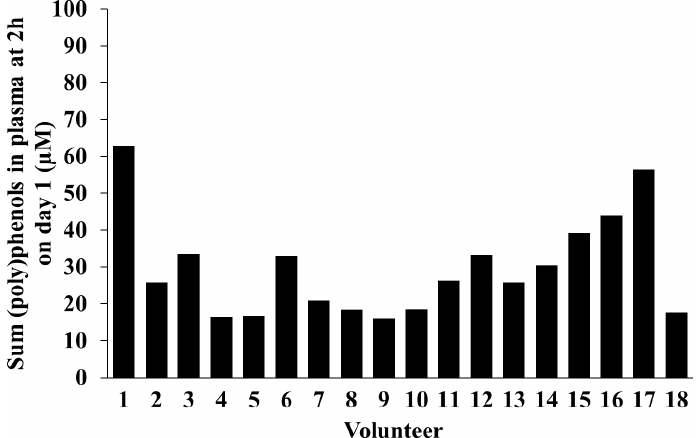
Figure 3. Total (poly)phenols concentration (µM) at 2 h post consumption of wild blueberries at Figure 2. Total (poly)phenols concentration ( µ M) at 2 h post consumption of wild blueberries at day 1 ( n = 18). day 1 ( n =